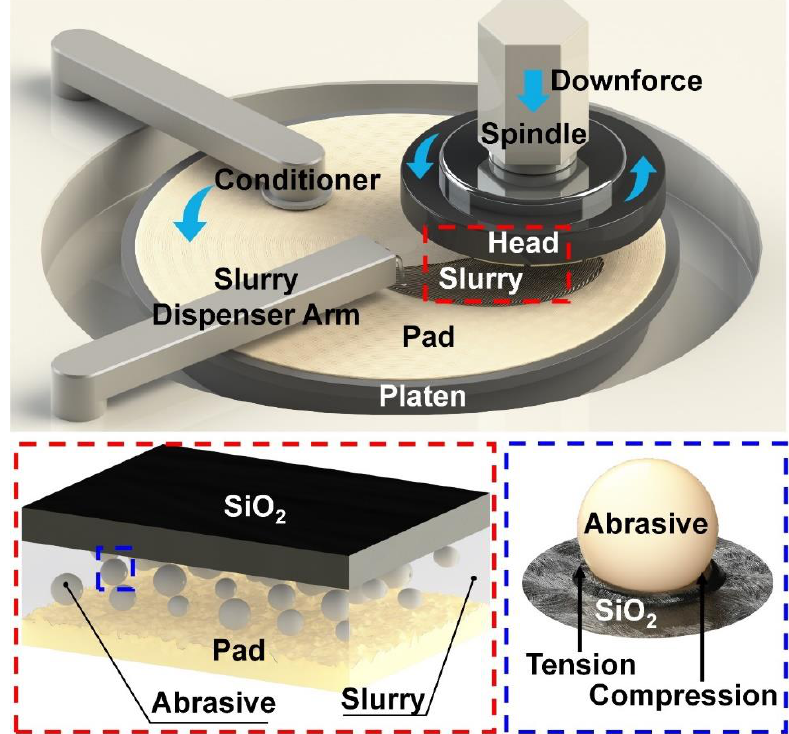
Figure 1. Schematic of oxide CMP and the interactions between the wafer, pad, and silica abrasives.